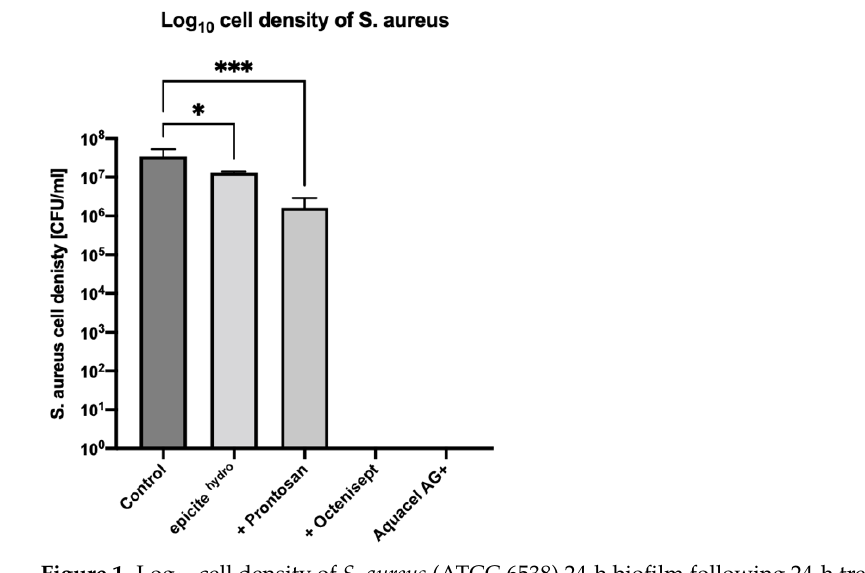
Figure 1. Log 10 cell density of S. aureus (ATCC 6538) 24-h biofilm following 24-h treatment with the test dressings. All dressings were tested in triplicate. Error bars represent standard deviation of the mean. Asterisks represent the significant difference between the samples and the untreated control ( p = 0.0055).